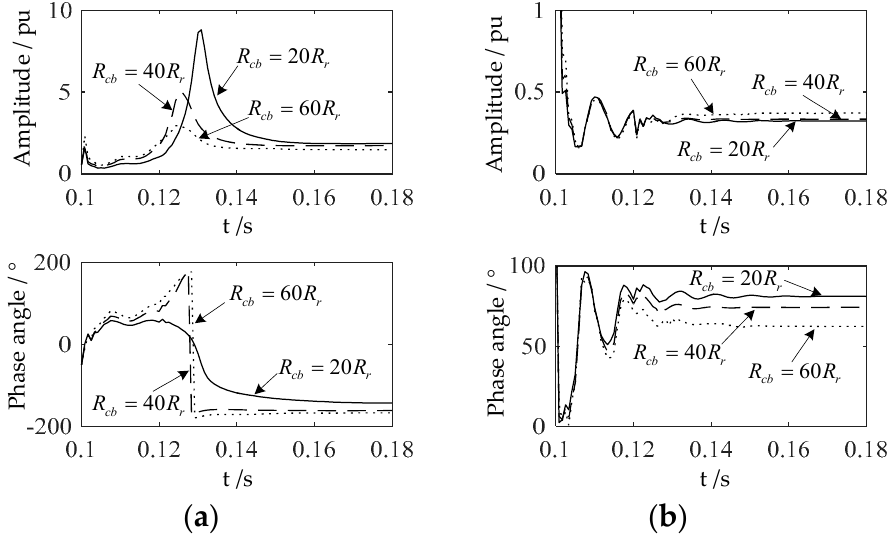
∗  and Z ∗ w − in Case 3: ( a ) Z ∗ Z and w + w 